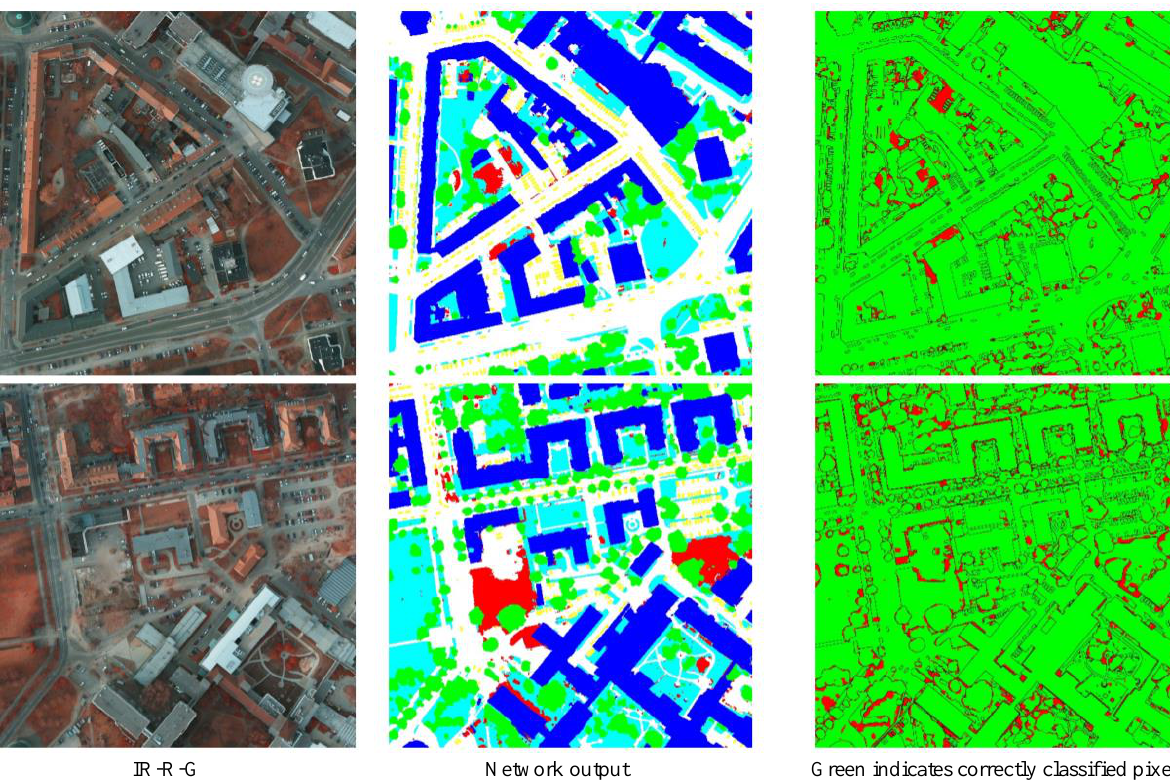
Figure 9. Sample network